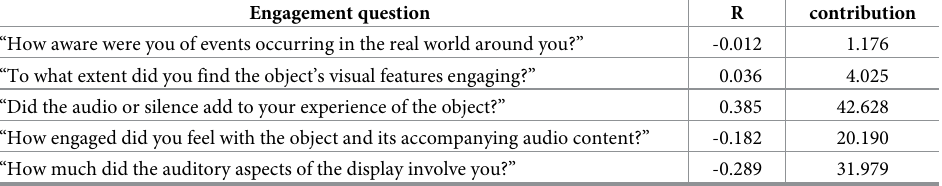
Table 5. Relationships between each engagement question and PC4. R denotes the Pearson correlation between each question and PC4, while contribution denotes the % of relative contribution of each individual question to PC4. Engagement question